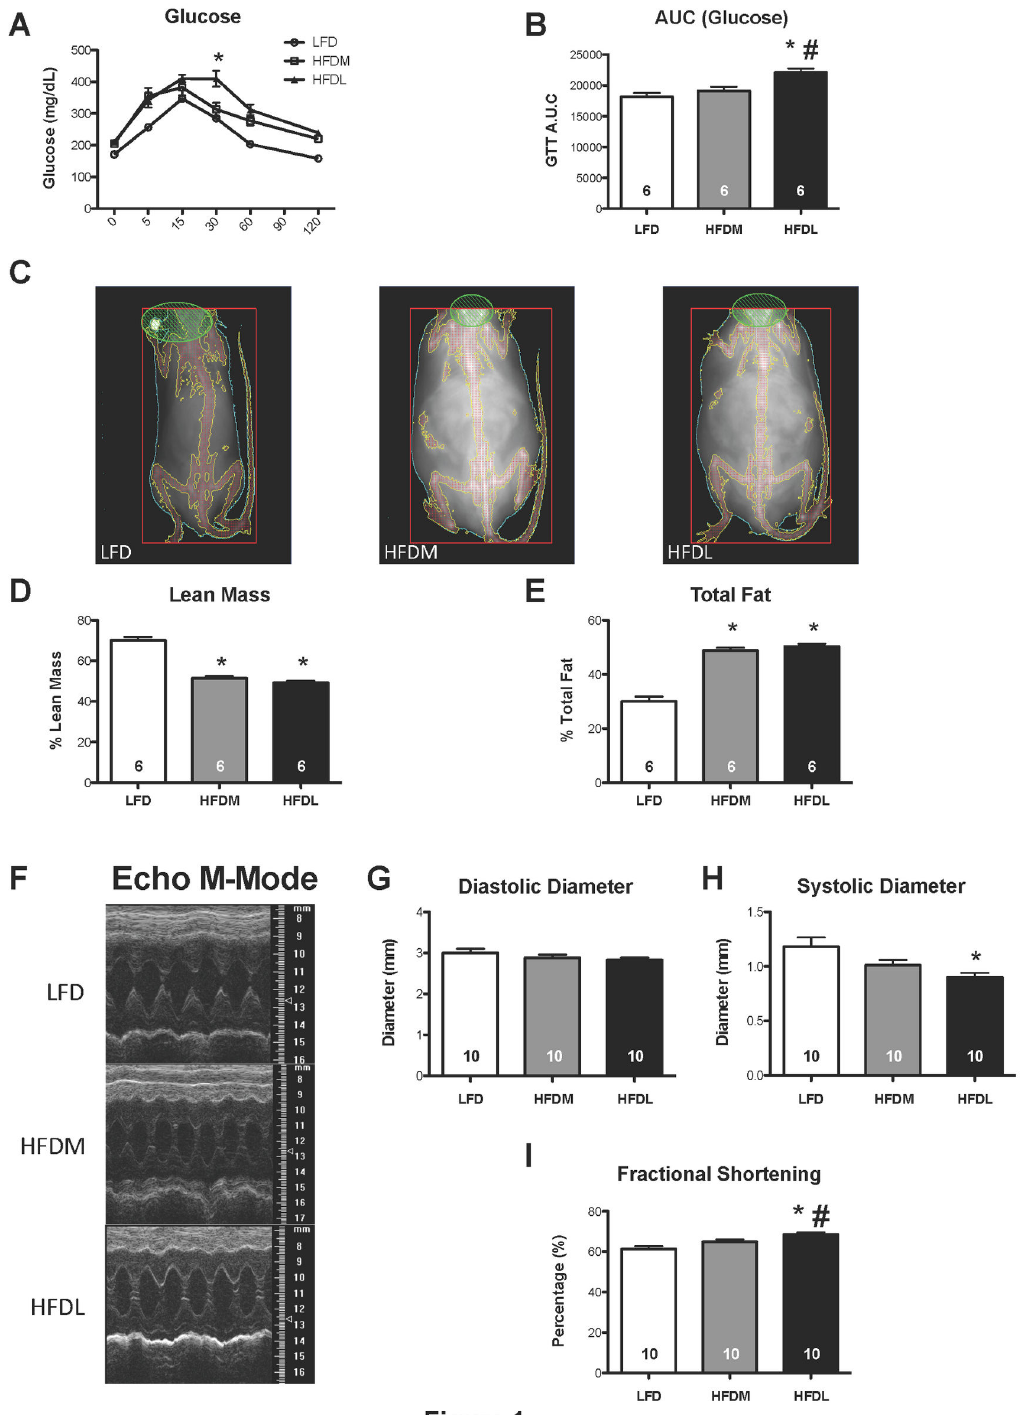
Figure 1. Long-term high fat diet results in altered cardiac function. ( A ) Glucose tolerance test (GTT) ( B ) GTT A.U.C. in LFD, HFDM and HFDL treated mice. ( C ) Dexascan images of LFD, HFDM and HFDL fed mice. ( D , E ) Quantitative dexascan analysis of total lean mass and fat mass expressed as percent of total body weight. ( F ) M-mode from conscious echocardiogram utilizing the Vevo 770 imaging system. ( G - H ) Diastolic diameter was not significantly altered in either HFD group. Systolic diameter was significantly decreased in HFDL compared to LFD. ( I ) Fractional shortening was significantly elevated in HFDL vs. LFD and HFDL vs. HFDM. Data are presented as mean ± S.E., *p< 0.05 vs. LFD, #p< 0.05 vs. HFDM. doi: 10.1371/journal.pone.0083174.g001 PLOS ONE |